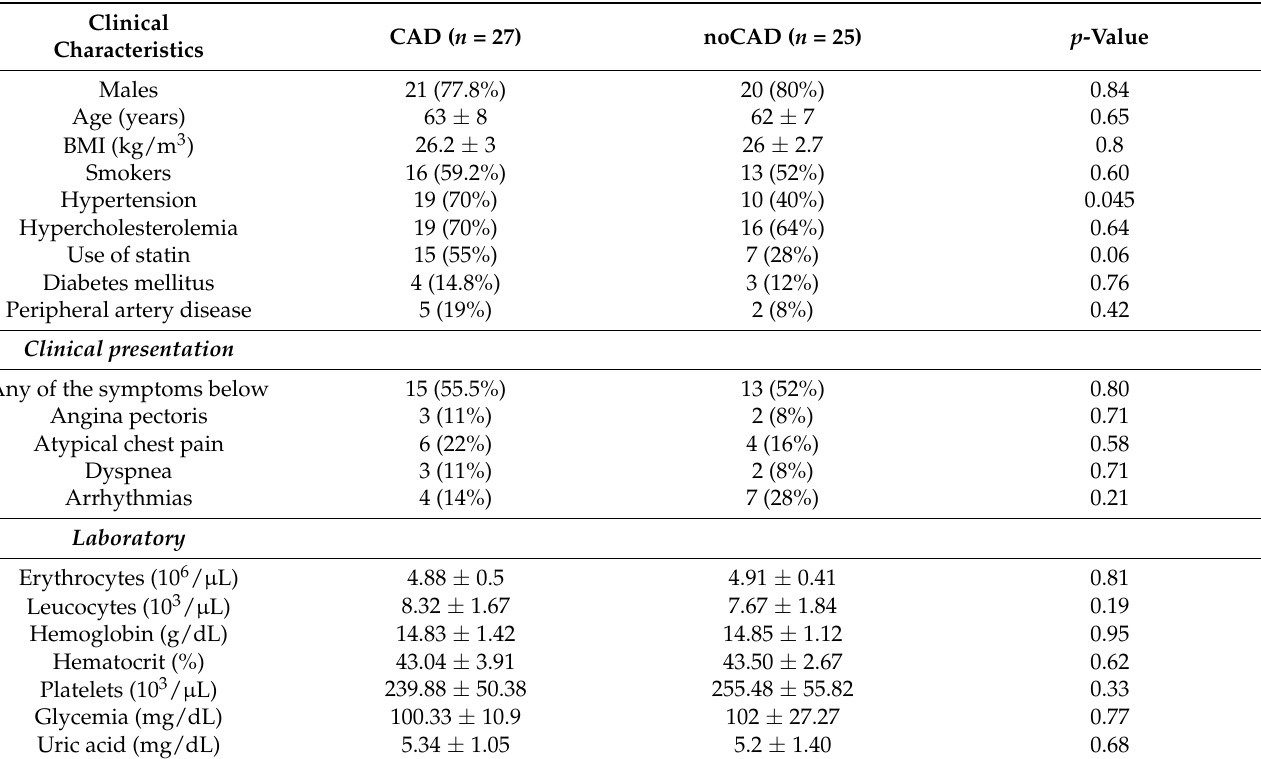
Table 1. Patient